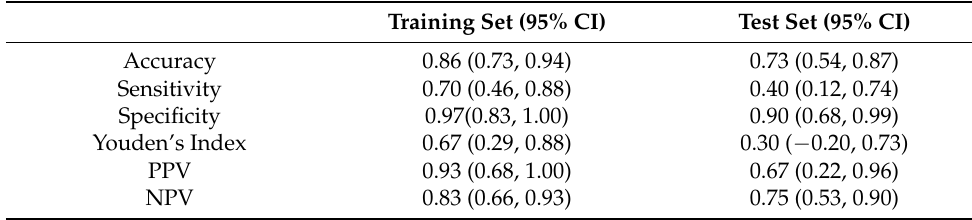
Table 2. Skill scores for the logistic regression model.